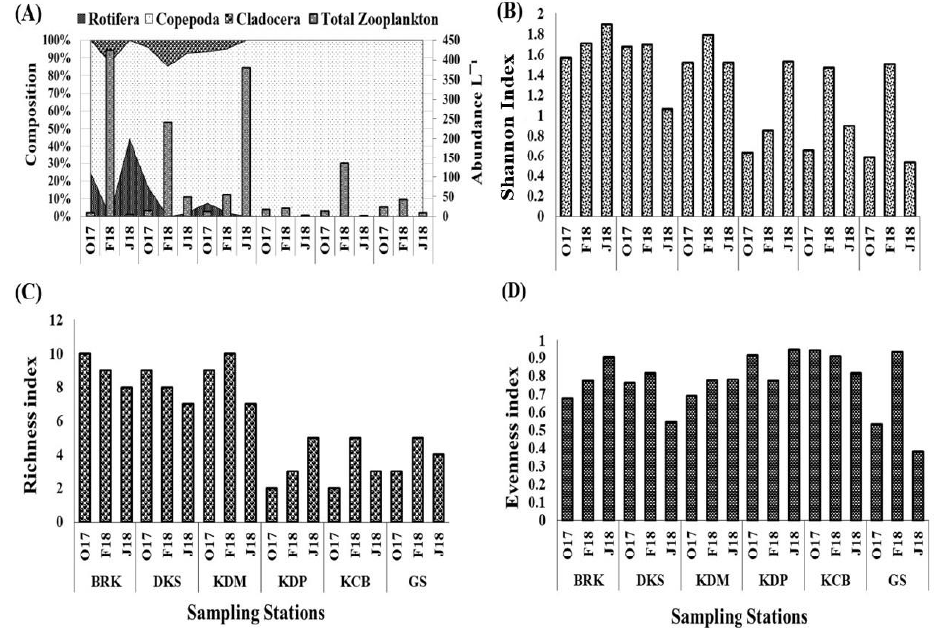
Figure 5. Percent (%) composition of Rotifera, Cladocera, Copepoda, and total zooplankton abun- dance (L − 1 ) ( A ), Shannon–Wiener index of diversity ( B ), species richness ( C ), and Simpson index for evenness ( D ) of zooplankton, recorded during October 2017, February 2018, and June 2018 at six selected stations in the HRE.